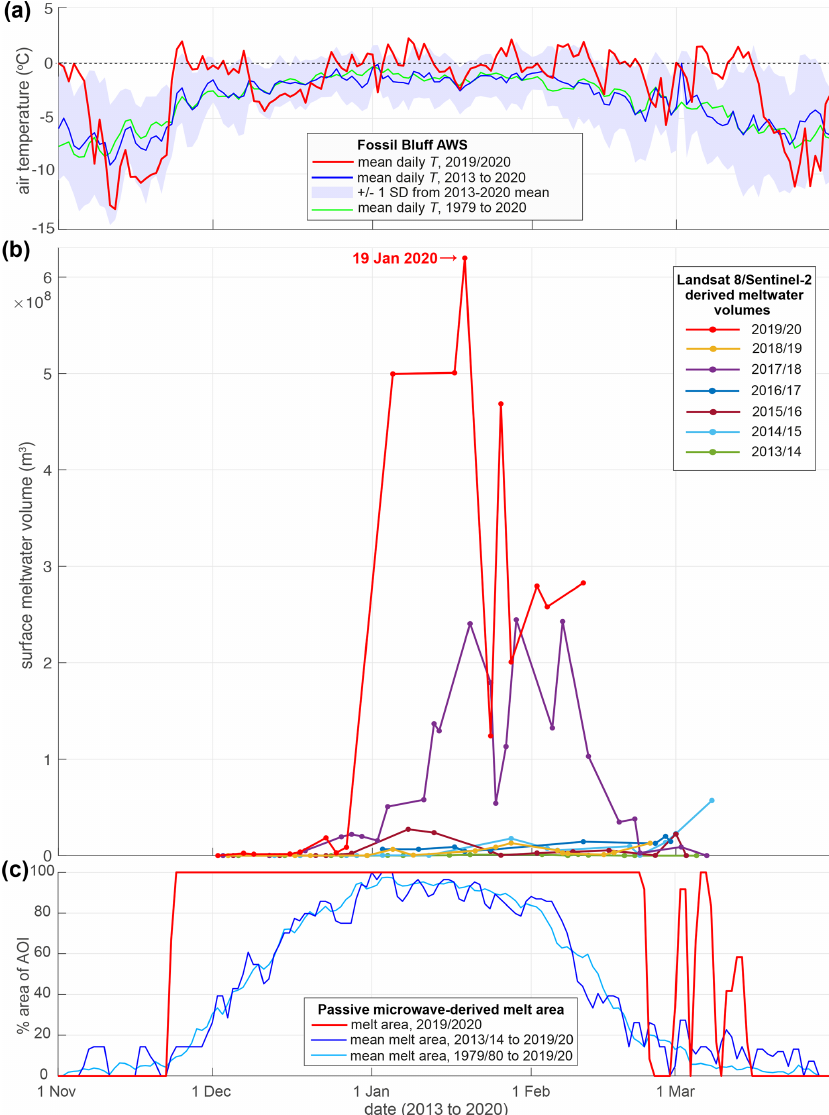
Figure 5. (a) Surface (2m) air temperature data from the Fossil Bluff AWS (location in Fig. 1b, yellow star). The daily mean air temperature for the 2019/2020 melt season is shown by the red line, daily mean temperatures for the seven melt seasons from 2013/2014 to 2019/2020 are shown by the blue line, ± 1 standard deviation from that blue line is shown by the areas of blue shading, and the daily mean temperature from 1979 to 2020 (using 12h data) is shown by the green line. The horizontal dashed black line depicts 0 ◦ C. (b) Calculated volumes of surface meltwater ponding in the GVIIS AOI from 2013/2014 to 2019/2020 derived from Landsat 8 and Sentinel-2 optical imagery. Data from mosaicked images are only plotted if the image includes > 10% of the study’s AOI (Fig. 1, red outline) that is cloud free; data from mosaicked images on 113 images total are shown. On dates when imagery does not cover 100% of the AOI, observed meltwater volumes are normalized to the AOI (see Sect. 3.3 for further details and Fig. S7 for a plot of all the observed meltwater volumes). (c) Microwave- radiometer-derived near-surface melt extent over the GVIIS AOI (Fig. 1b, red outline) as a % of the total area (7556km 2 ). Daily areas of melting for 2019/2020 are shown by the red line, the daily mean area of melting from 2013/2014 to 2019/2020 is shown by the dark blue line, and the daily mean area of melting from 1979/1980 to 2019/2020 (excluding 1987/1988) is shown by the light blue line.